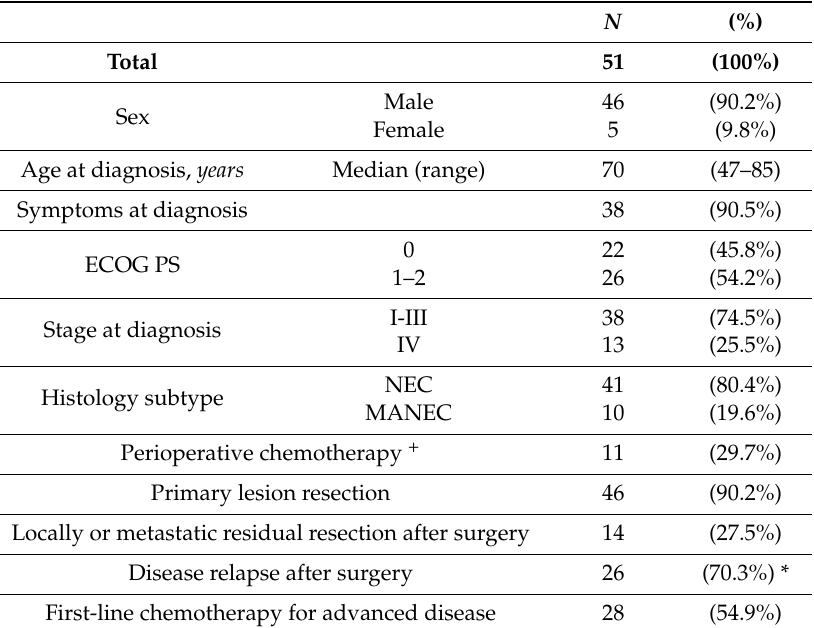
Table 1. Patient